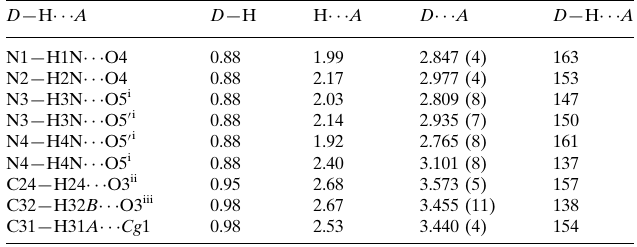
Hydrogen-bond geometry (A˚ , (cid:2) ). Cg 1 is the centroid of the C1–C6